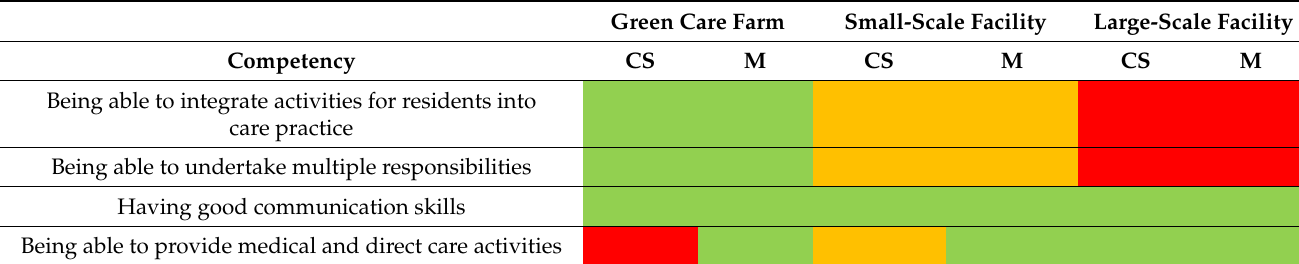
Table 3. Identified competencies and differences between facilities and